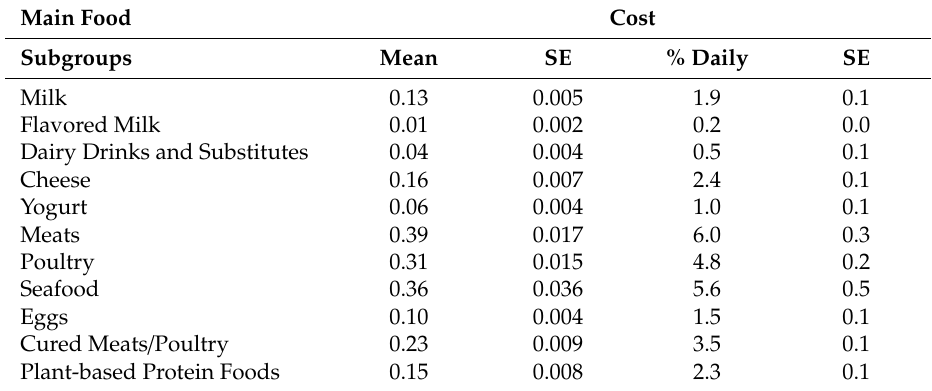
Table 6. Percent daily cost ($) of eggs vs. other protein food subgroups in